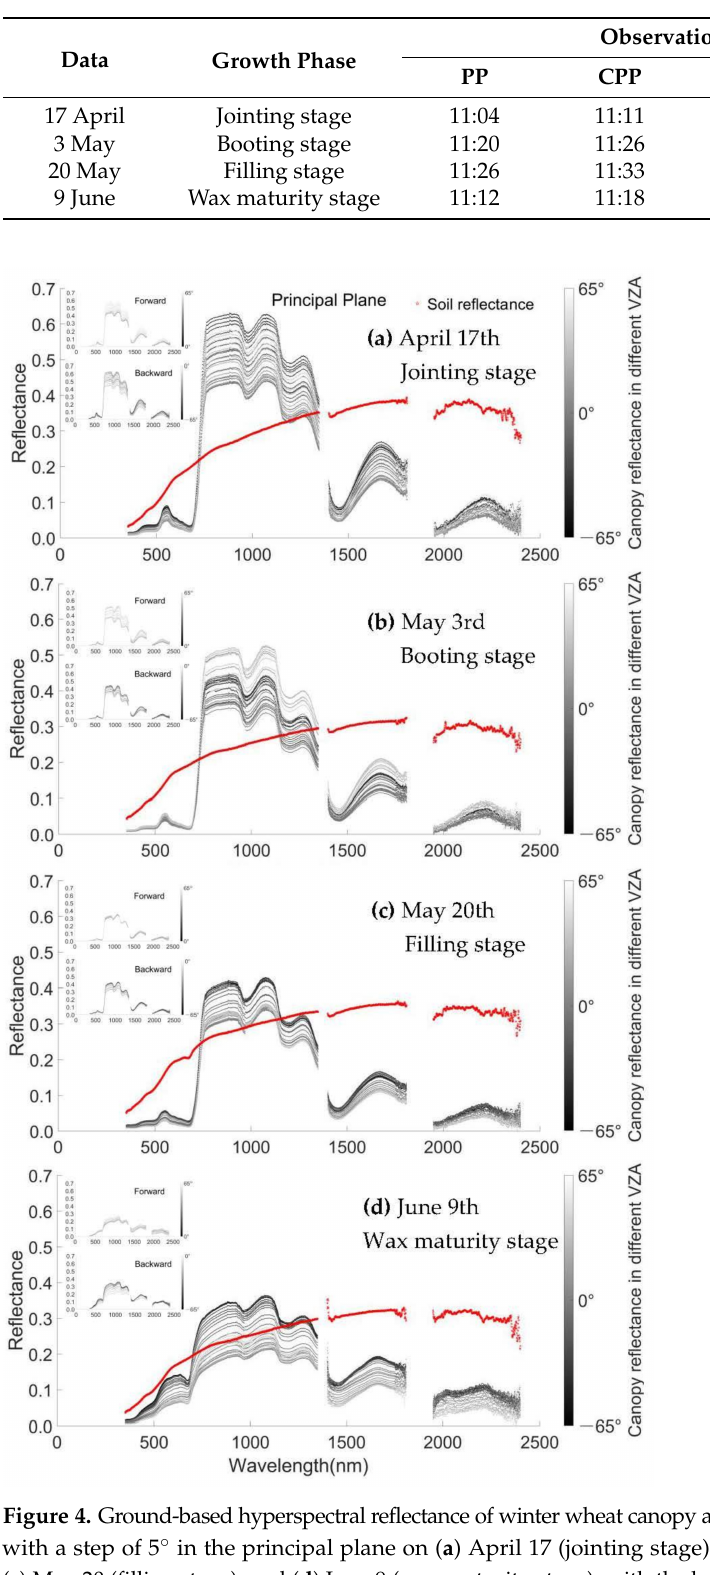
Table 4. Crop growth phases at different dates and observation time based on ground hyperspectral data, where PP, CPP, AR, CR represent principal plane, cross-principal plane, along-row and cross- row, respectively.